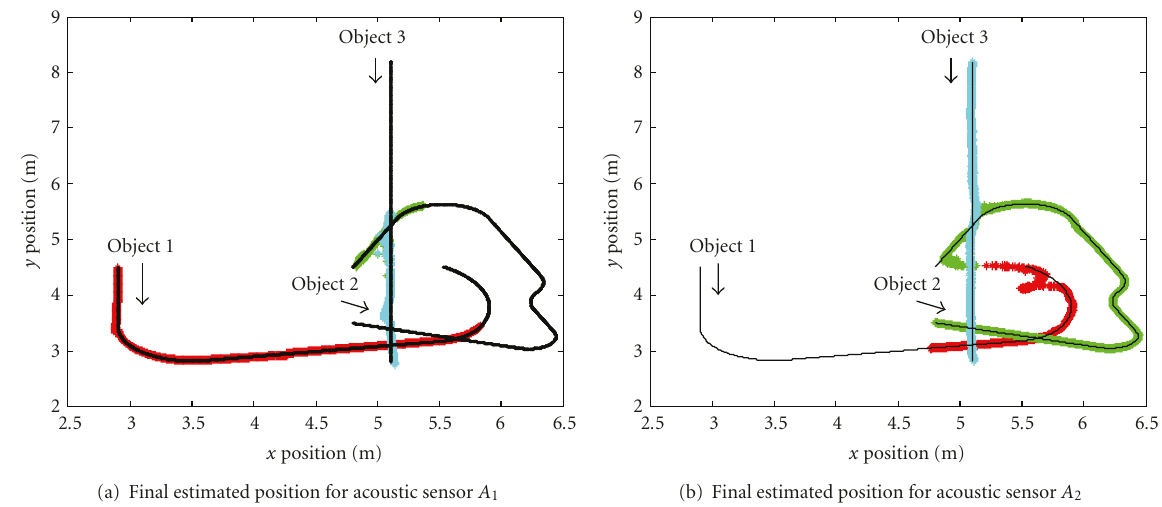
Figure 22: Final estimated position for acoustic sensors A 1 and A 2 .